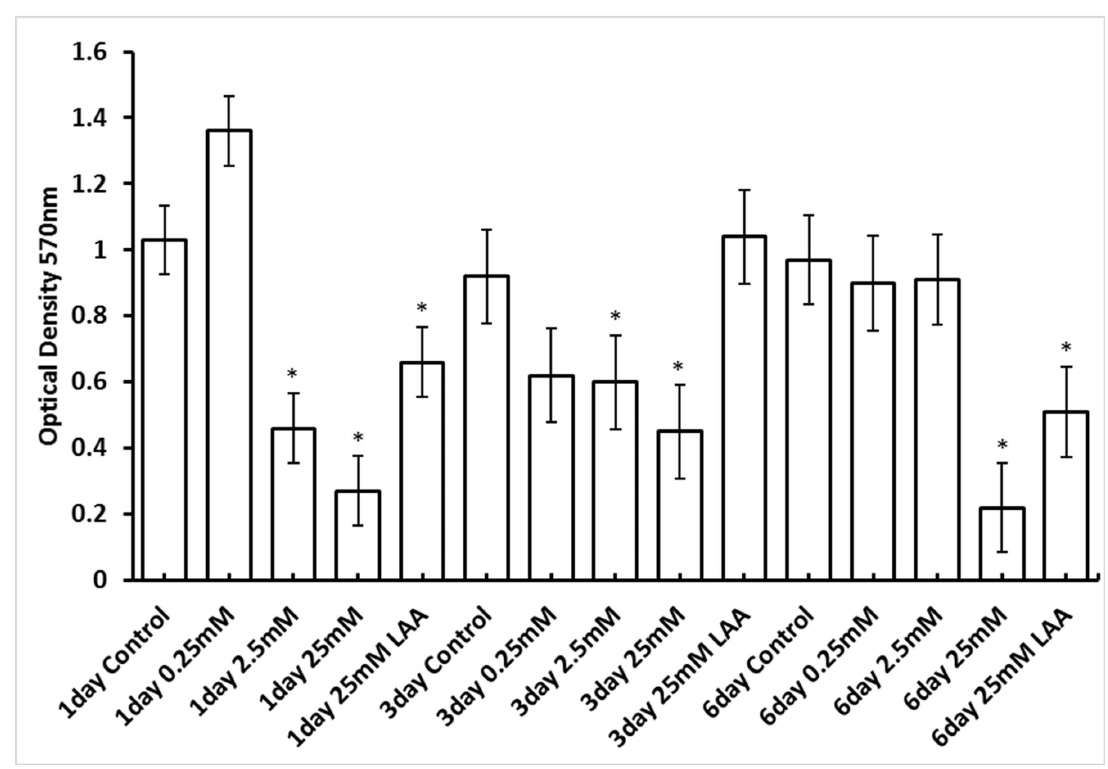
Fig 3. Mean optical density (570nm) of Control group (no amino acids) versus treatment group (D- or L-amino acids). Biofilm growth followingstaining of E . faecalis biofilms with crystal violet. For biofilms grown over 1 day, D-Leu, D-Met and D-Trp were added duringinoculationof bacteriaat a concentration of either 0.25, 2.5 or 25 mM. The concentration of D-Tyr was 0.25mM in all experimental groups. The same concentrations of DAAs were added at 1or 3 days for biofilms grown for a total of 3 and 6 days respectively. L-amino acids (L-Leu, L-Met and L-Trp) were also includedas a control at a concentration of 25mM with L-Tyr at 0.25mM. Asterisk denotes a significantreduction (p < 0.05)in biofilm compared to the control (no